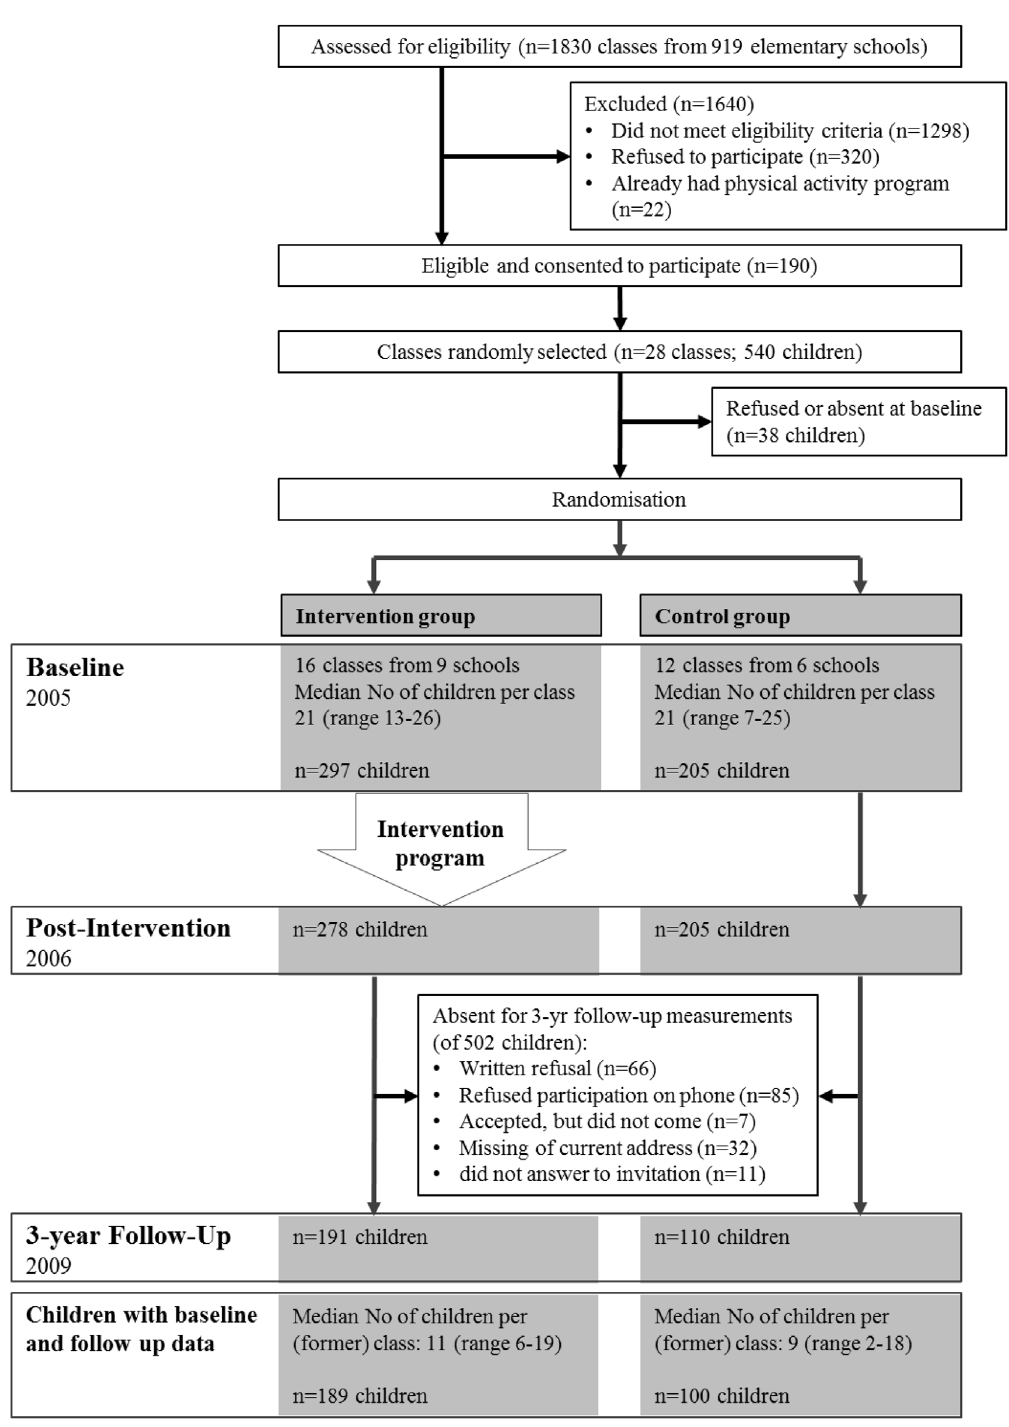
Figure 1. Flow of individual participants through study with outcome measures. Post-intervention results have been published elsewhere [14]. doi:10.1371/journal.pone.0087929.g001 intervention effects for the sum of four skinfolds ( 2 0.42 ( 2 0.68 to 2 0.15); p= 0.002) and waist circumference ( 2 0.37 ( 2 0.65 to 2 0.09); p= 0.009). Reported time spent in sports club was significantly higher in the intervention than the control group (reported difference: 72 min per week (95% confidence interval: